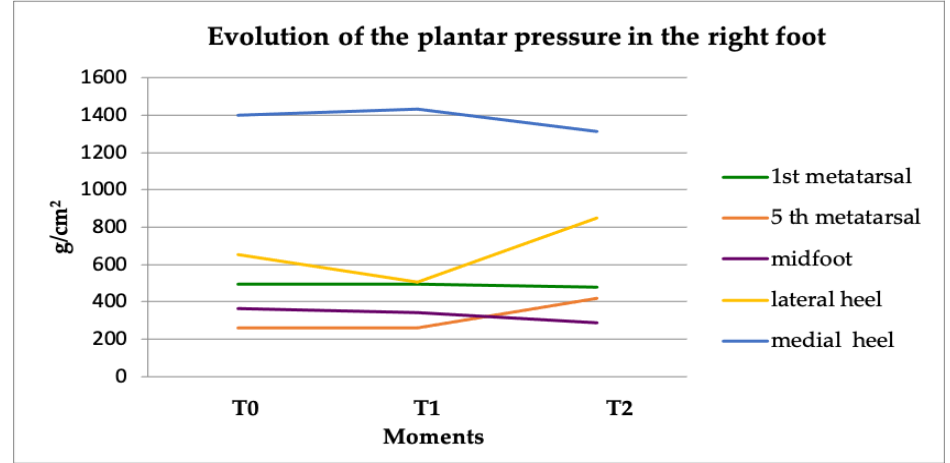
Figure 2. Evolution of plantar pressure in the right foot. Statistical analysis revealed that the sensor for the 5th metatarsal area ( p = 0.05) to- gether with the one corresponding to the midfoot plantar surface ( p = 0.04) recorded sig- nificant values at 15 min after applying the oral splint on the right side (Table 1). Table 1. The values of pressure recorded from the sole in the right foot (the same side as the occlu- sal imbalance) . Pressure Value (g/cm 2 )